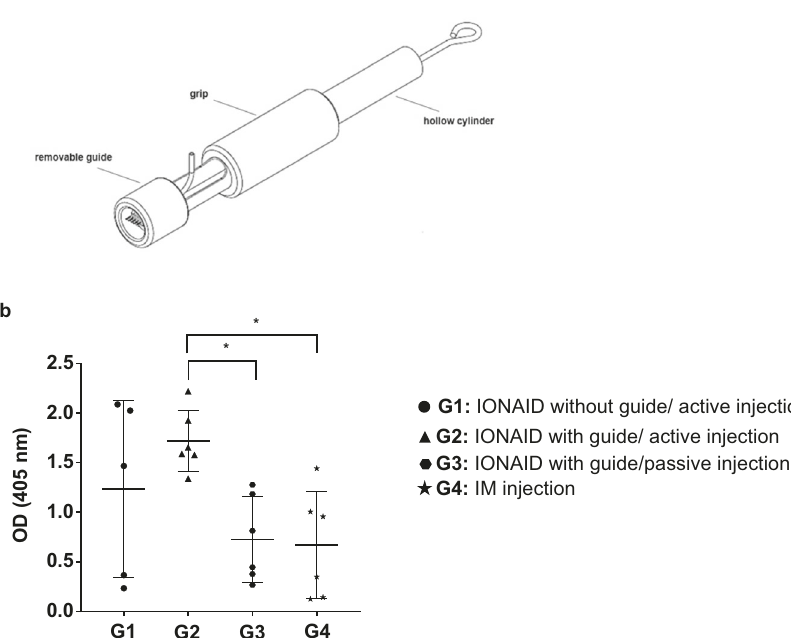
Fig. 5 ZGP-enhanced humoral immune responses by IONAID in guinea pigs. a Close up of a needle array mounted in the hollow cylinder with the removable plastic guide. b ZGP IgG responses from immunized groups of guinea pigs ( n = 6/group) after vaccination with 300 µg of pIDV-II-EboV-GP-M06. Antibodies responses were analyzed by ELISA at day 35 from serum samples, which were used in a 1/400 dilution. The horizontal line represents the mean of all animals. Vertical lines represent the standard deviation (SD). Statistical analysis was made using one- way ANOVA, followed by Tukey multiple comparisons test. Asterisks denote statistically signi fi cant data ( *P < 0.05). Table 1. Variability of humoral immune responses after vaccinations. Mean